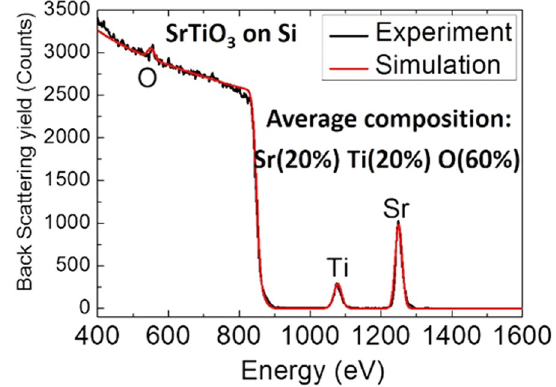
Figure 6. Rutherford back scattering spectra on the 10 nm thin film synthetized at 360 °C. The experiment (black curve) shows the same stoichiometry as the simulated ideal STO (red curve).